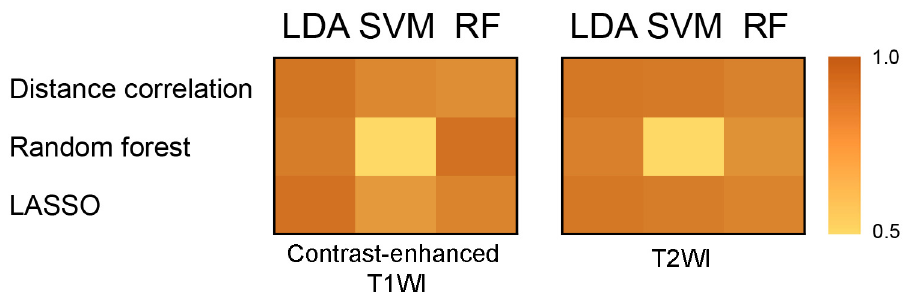
Figure 3. Heatmap of the performances of models based on the area under the receiver operating characteristic curve of the validation cohort, using features extracted from the contrast-enhanced T1WI and T2WI.